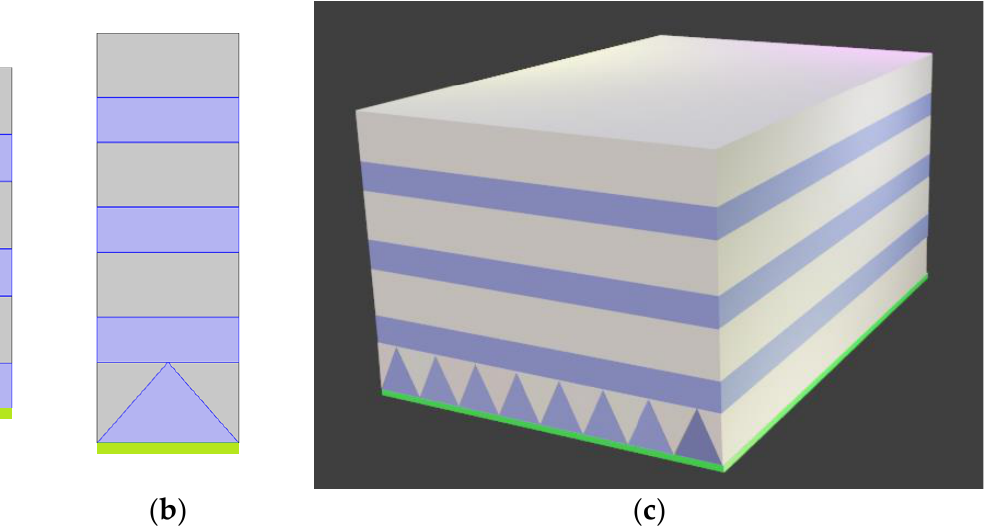
Figure 1. Geometry of the OTS-supporting nanophotonic structures under consideration. ( a ) Bragg reflector (1D photonic crystal) with 3-layer pairs and a plasmonic coating (Drude-type free electron plasma conductor). ( b ) The same structure with a blazed diffraction grating embedded between the distributed Bragg reflector and the plasmonic coating (only a single unit cell is shown). ( c ) 3D presentation of the structure. ( b ) In all images, grey surfaces correspond to n = 1.46 (silicon dioxide), violet represents n = 2.07 (tantalum pentoxide), and green layers at the bottom represent plasmonic coatings (either MXene or gold).